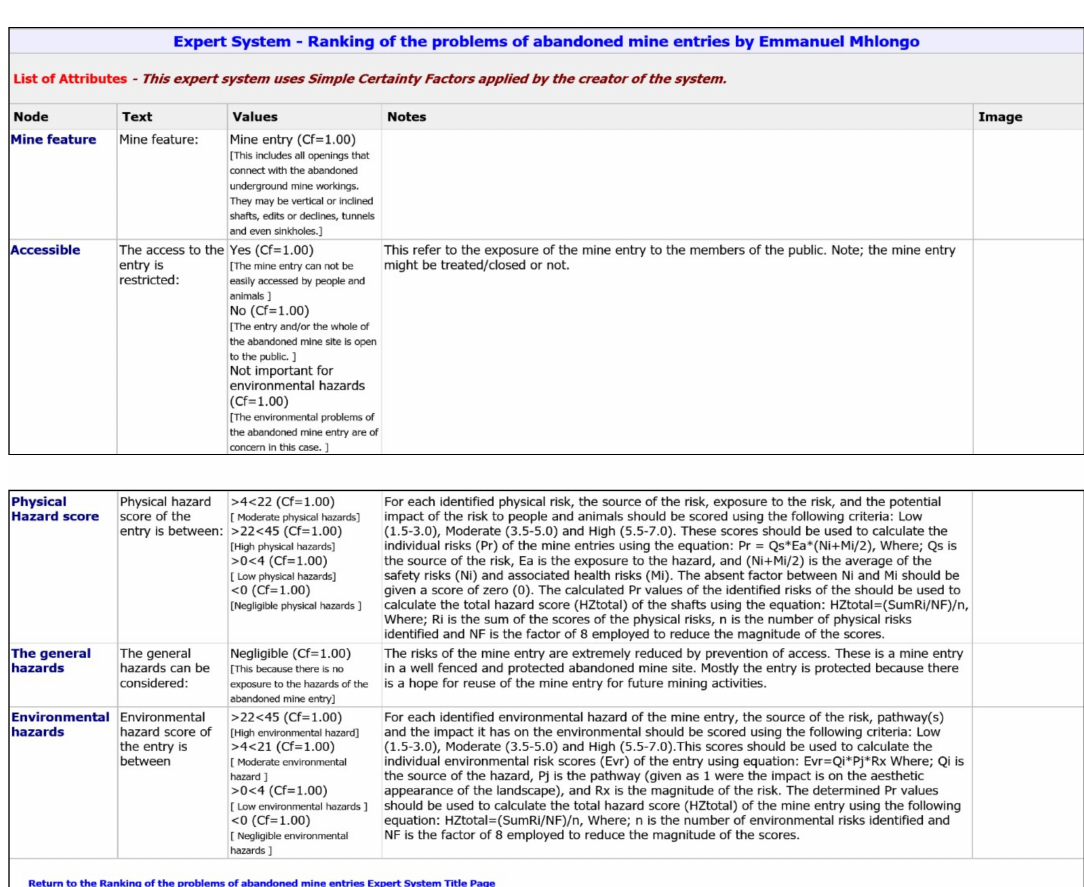
Figure A2. The list of the attributes of the